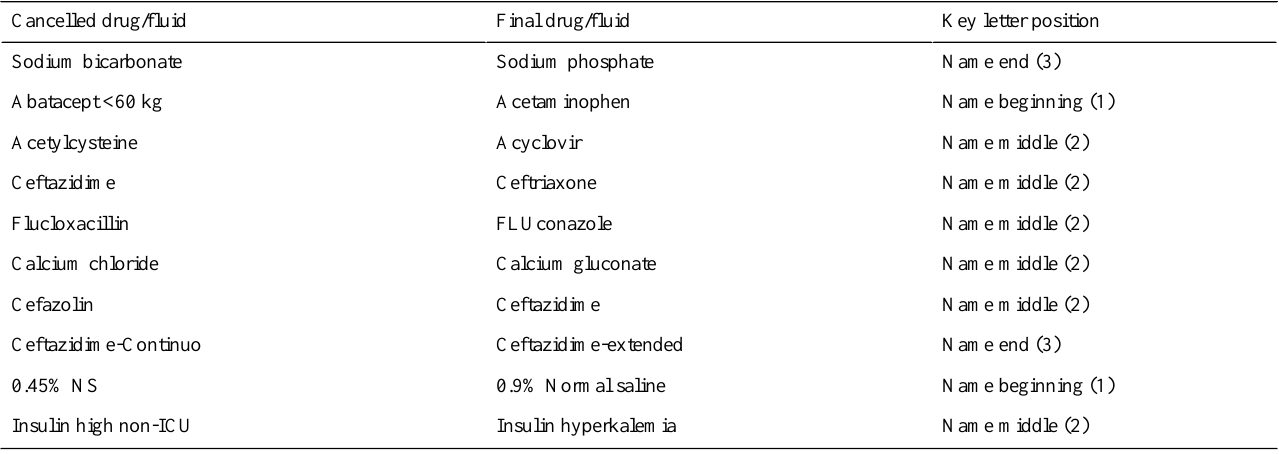
Table 5. Examples of cancelled infusion medication names and corrected medication names.